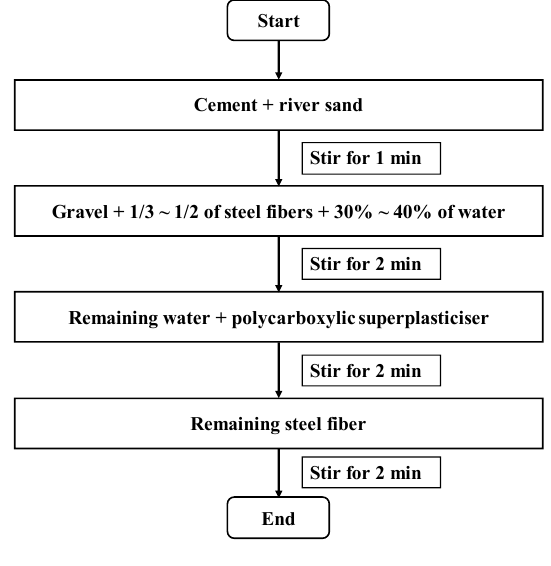
Figure 2. Mix procedures.